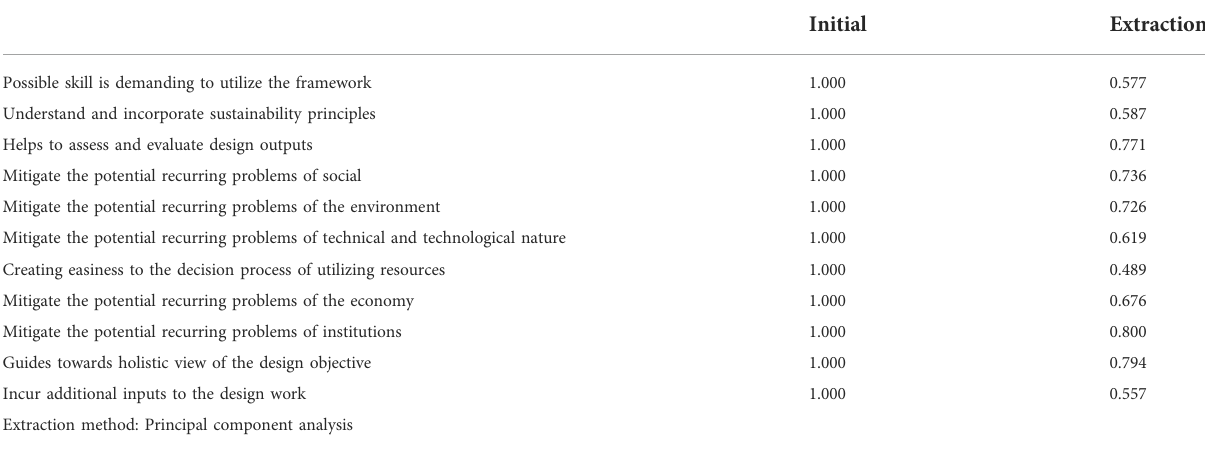
TABLE 6 Key roles of MCF communalities extracted. Communalities